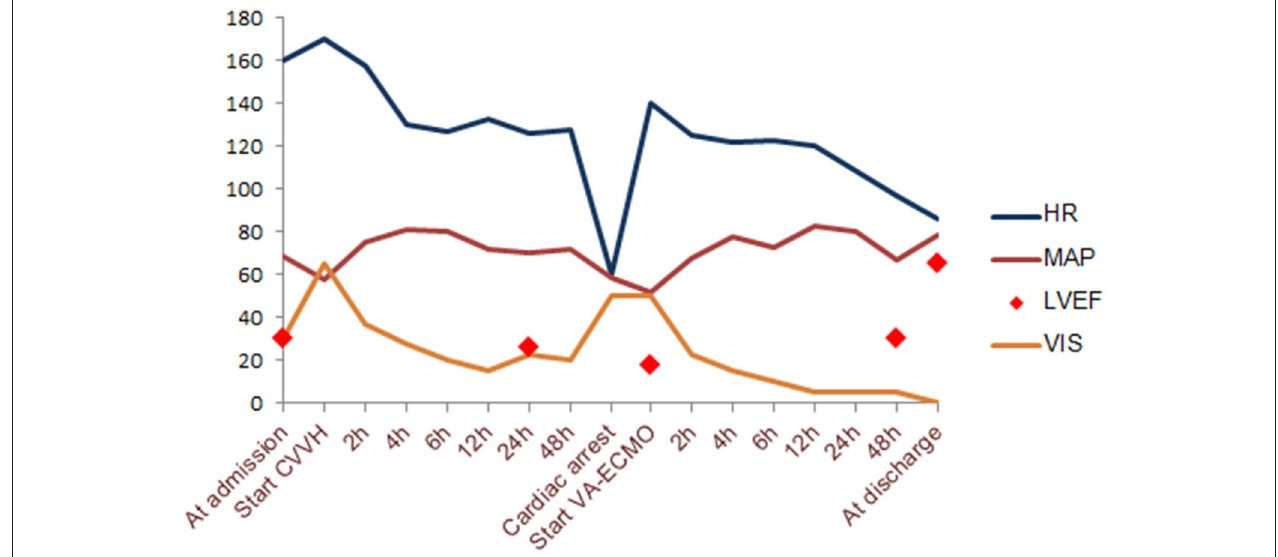
FIGURE 2 | Hemodynamic change according to timeline during supportive extracorporeal treatment modalities. VIS, vasoactive-inotropic score; LVEF, left ventricular ejection fraction; MAP, mean arterial pressure; HR, heart rate.